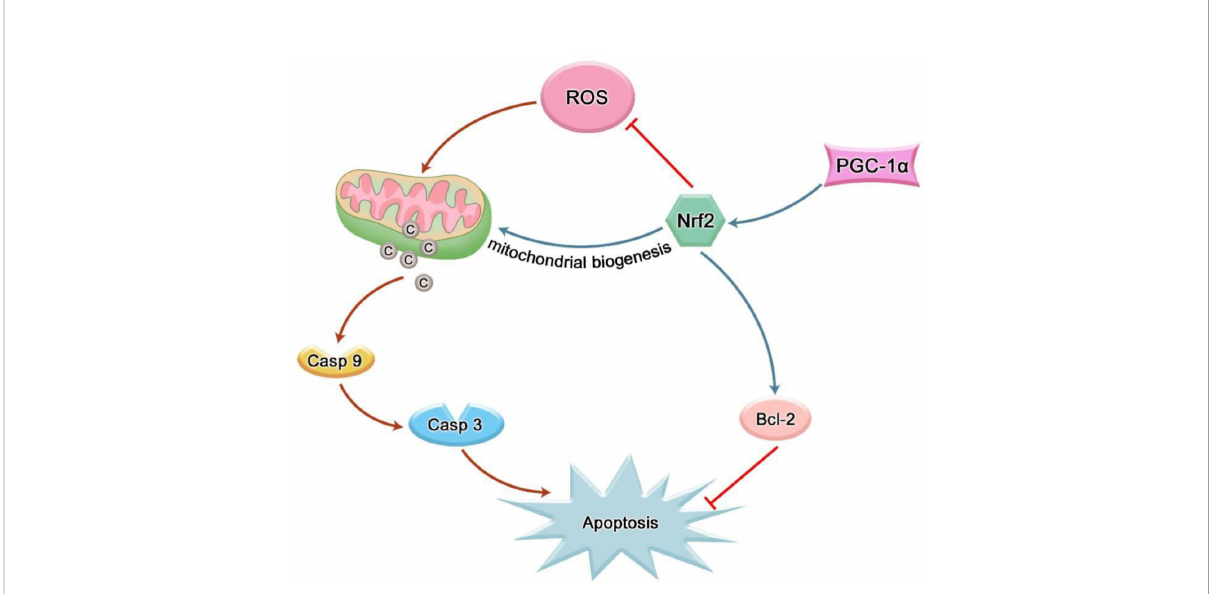
FIGURE 4 Nrf2 can inhibit cell apoptosis by reducing intracellular ROS; Nrf2 can indirectly inhibit cell apoptosis by participating in mitochondrial biogenesis; Nrf2 can also inhibit apoptosis by directly mediating the transcription of anti-apoptotic